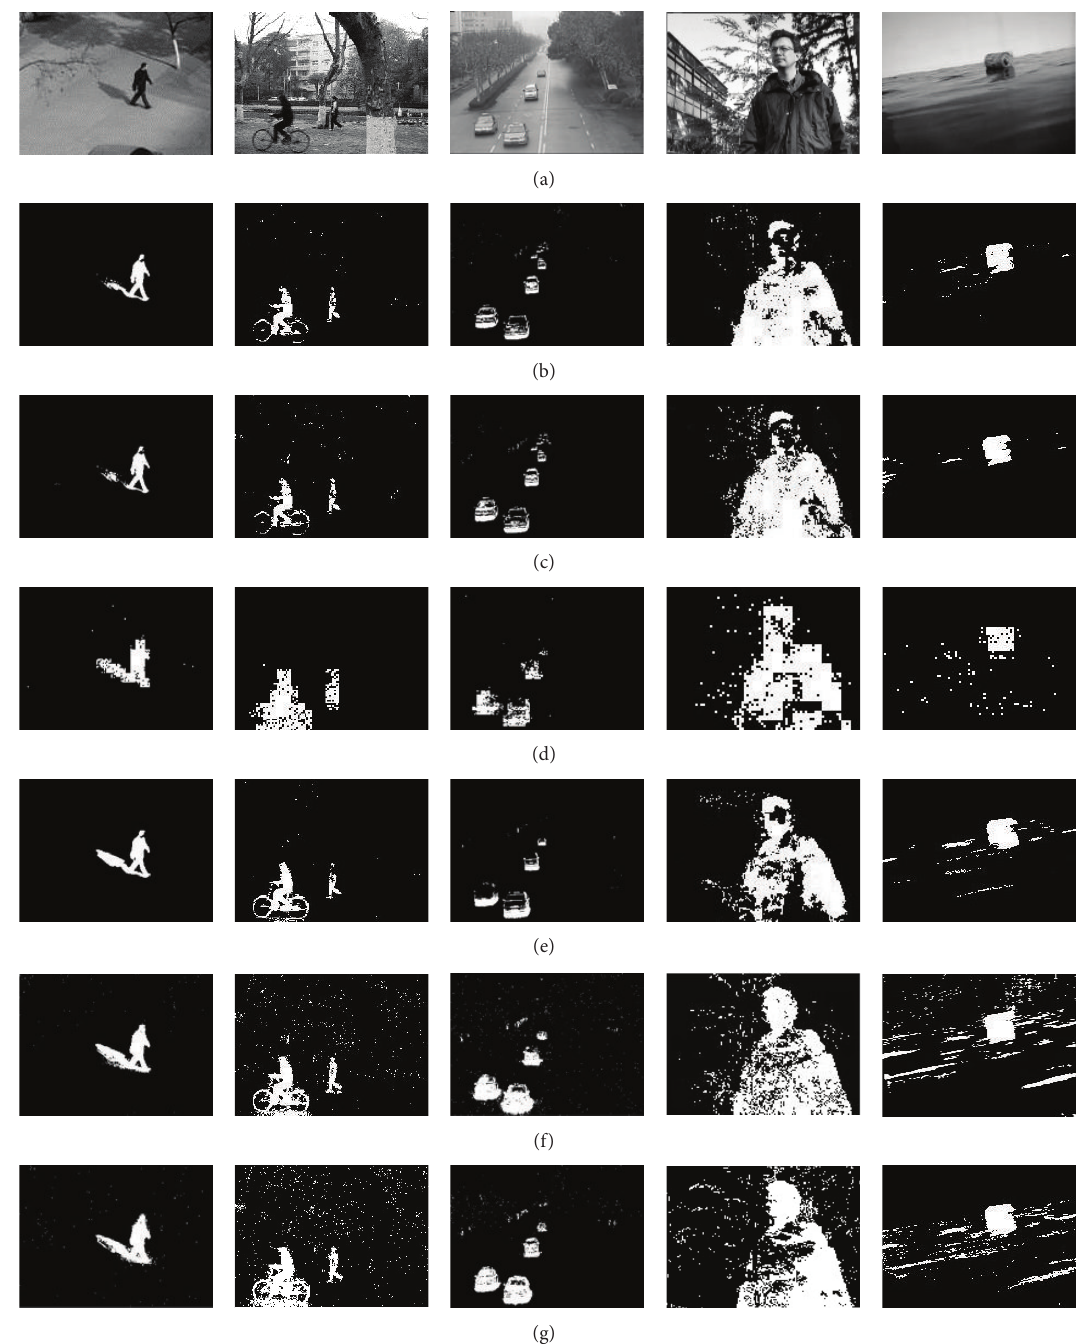
Figure 3: Comparative foreground masks of six methods. (a) Original frames, (b) our method, (c) ARCS, (d) CS-MoG, (e) ViBe, (f) KDE, and (g)